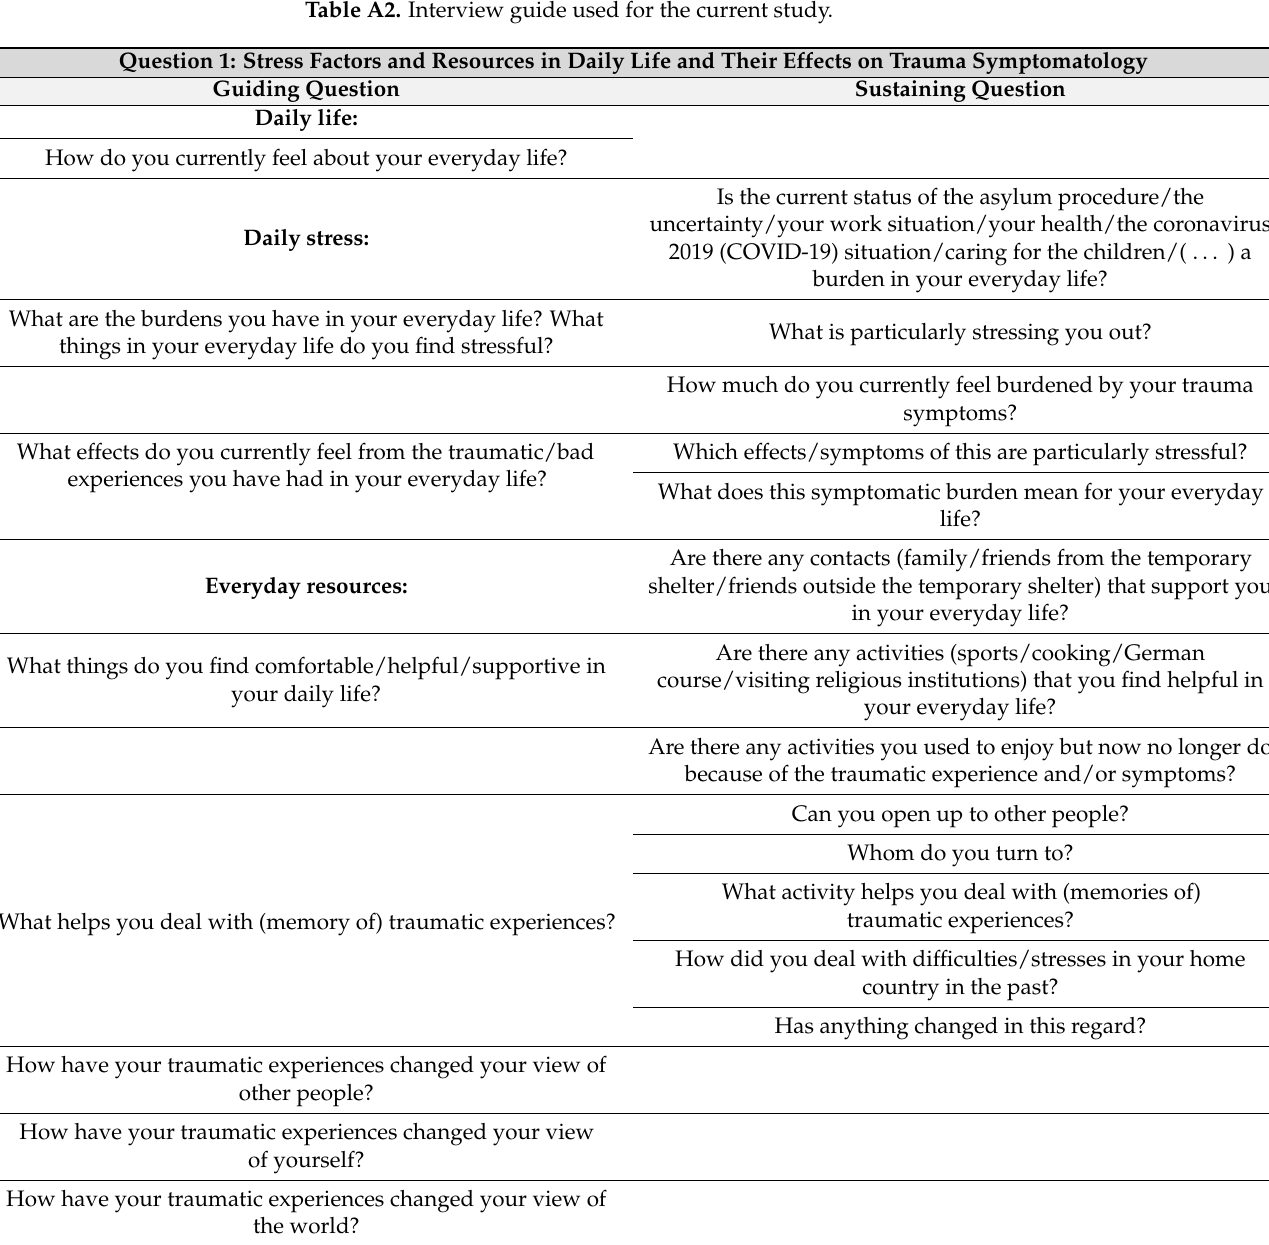
Table A2. Interview guide used for the current